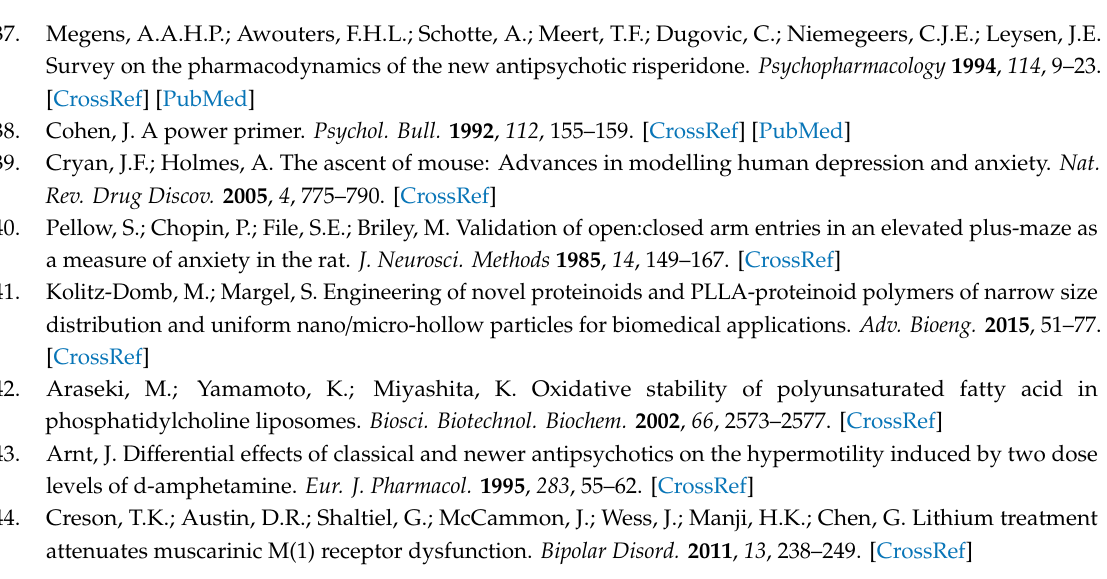
Sample Availability: Samples of the compounds are not available from the